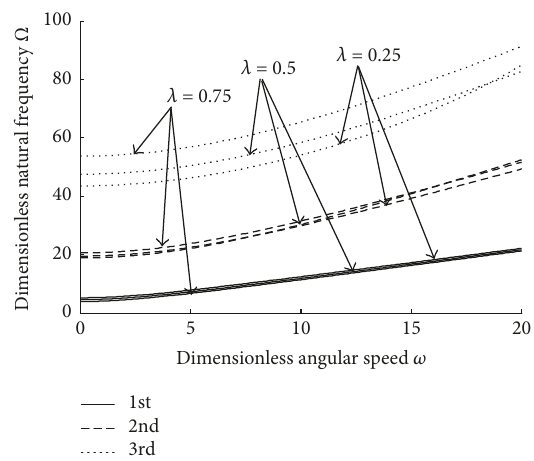
Figure 6: Variation of the first three dimensionless natural fre- quencies of rotating solid tapered beams with dimensionless angular speed of the hub for various 𝑟 0 = 0, 0.5, 1 at 𝜆 = 0.5 , 𝑟 = 1/30 .